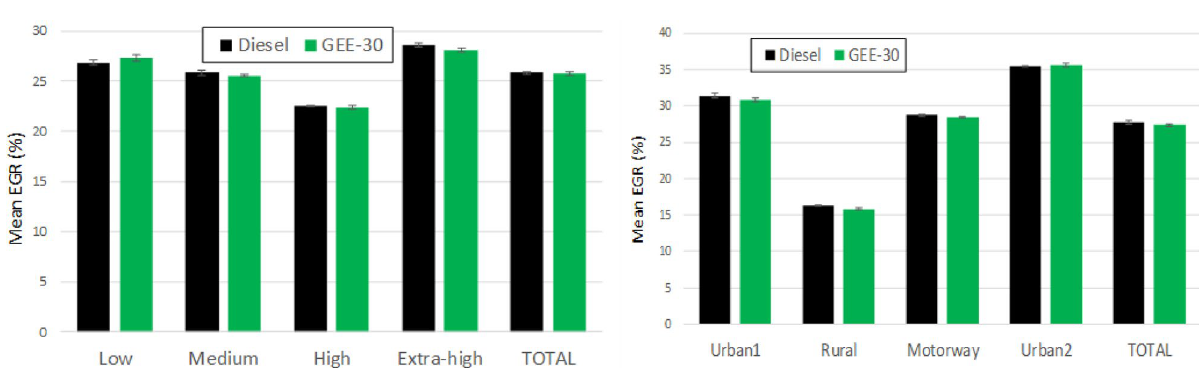
Figure 5. Mean equivalence ratio for the different phases of WLTC (left) and RDE (right).